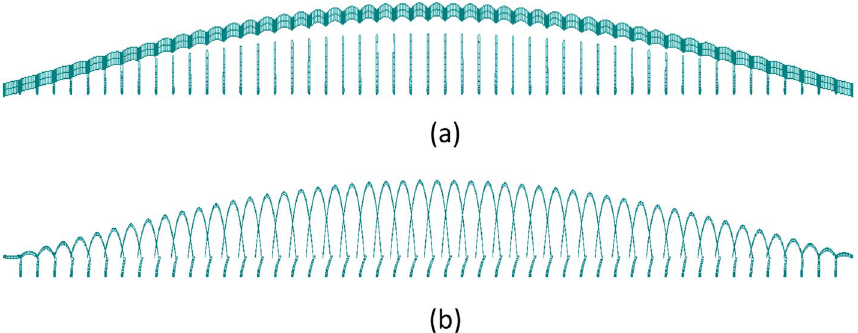
Fig. 12 Fundamental natural modes: a lateral mode; and b vertical